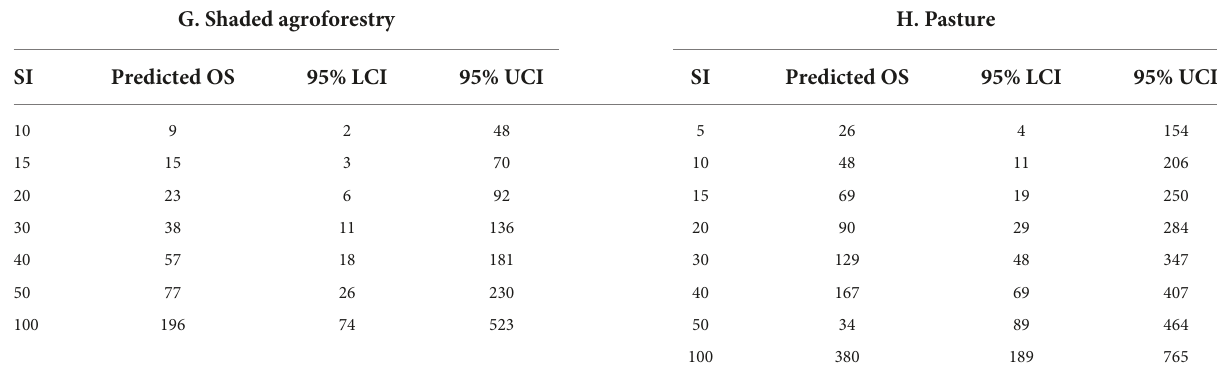
G. Shaded agroforestry H.